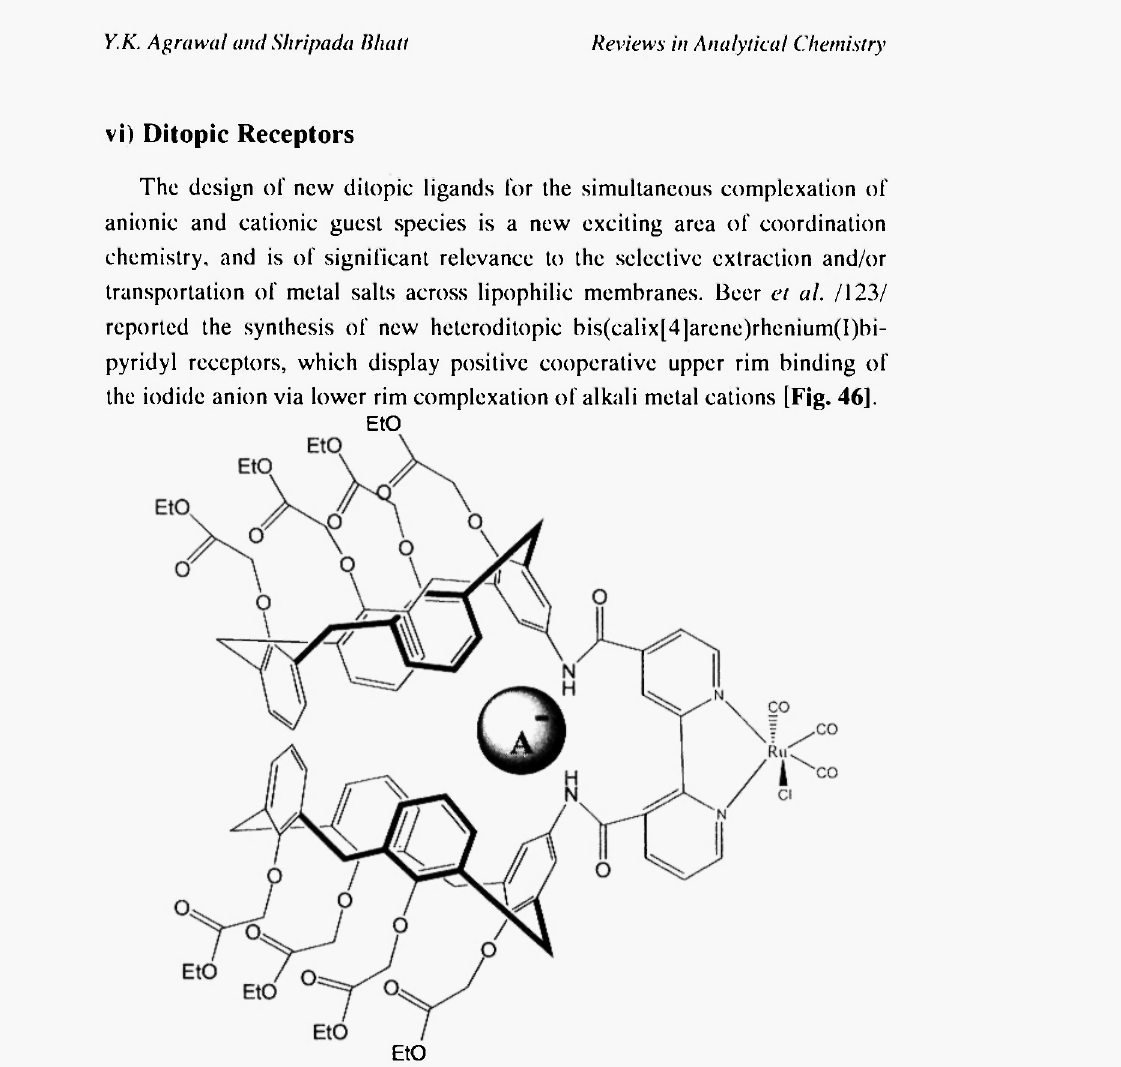
Fig. 46: Heteroditopic bis(calix[4]arene)rhenium(I)bi-pyridyl receptors They also reported a heteroditopic bis[calix[4]arene] ferrocene receptor. It has been shown to bind a variety of anions like iodide and bromide on the upper rim and alkali metal cations on the lower rim. They found that the selectivity and strength of anion binding depends on the nature of the bridging group, with a ferrocene-containing receptor binding much more weakly than its rhenium (I) bipyridyl analogue [Fig.